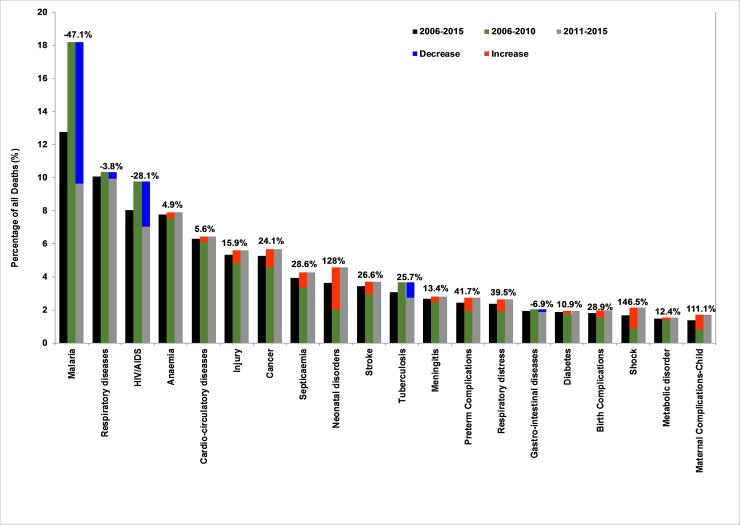
Comparing pattern of cause of death between 2006–2010 and 2011–2015 periods for all age groups.The blue bars indicate the causes with decreasing trend. Red bars indicate those with increasing trend. The actual percentage increase or decrease is shown as data label for each cause.